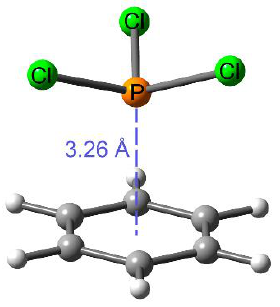
Figure 11. The Cl 3 P···benzene complex [159].